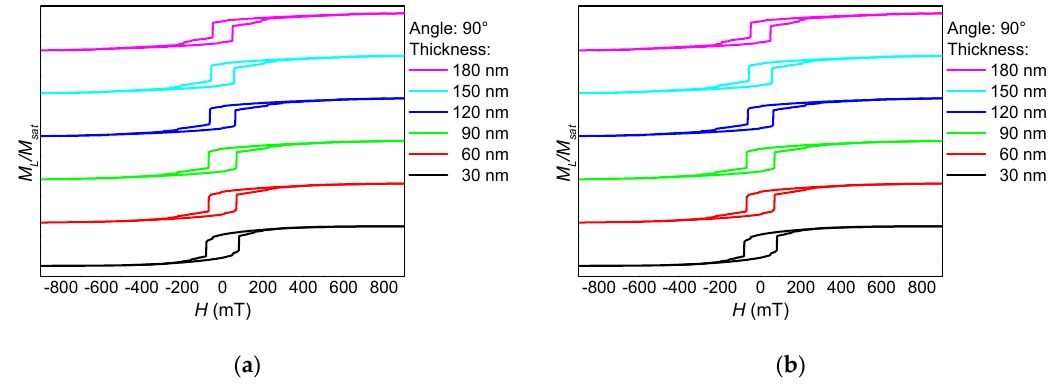
Figure 4. Thickness dependence of ( a ) the longitudinal and ( b ) the transverse hysteresis loops, simulated for a sample NF1 under an angle of 90°.